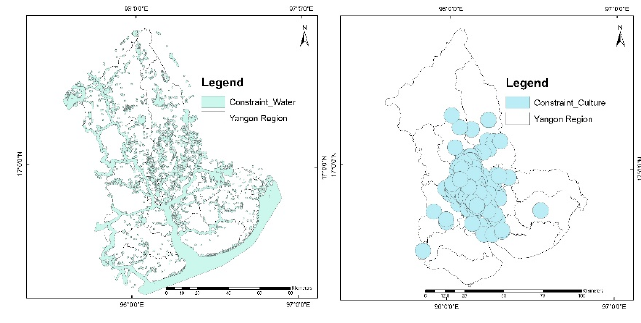
Figure A1. Constraints Map.